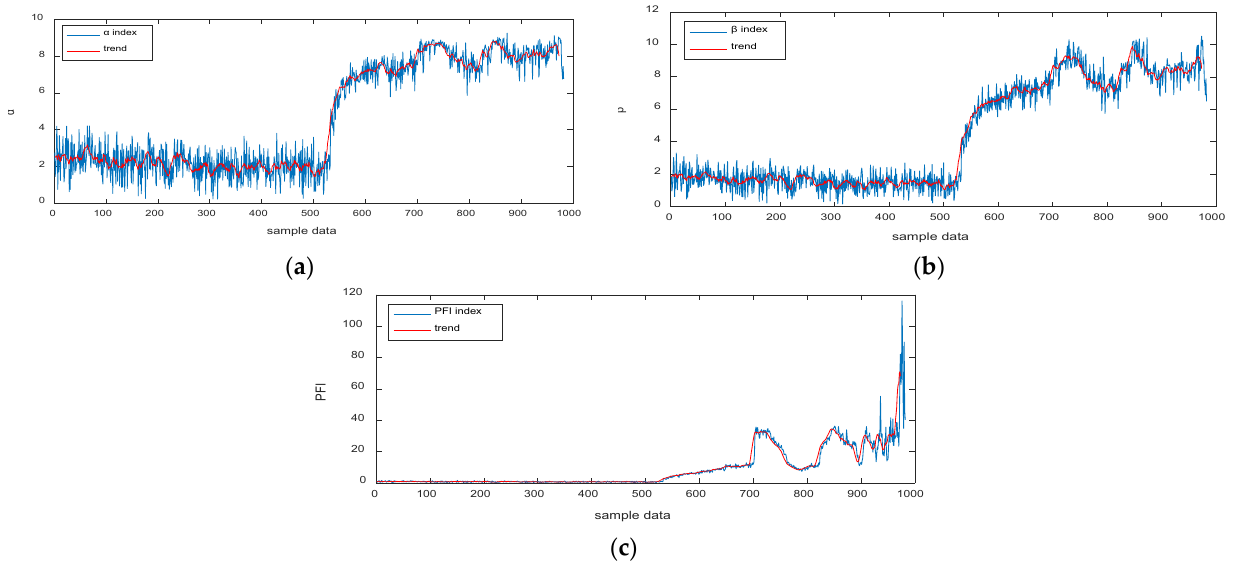
Figure 14. α, β, and PFI indexes ; ( a ) α index; ( b ) β index; ( c ) PFI index. Figure 14. α , β , and PFI indexes; ( a ) α index; ( b ) β index; ( c ) PFI